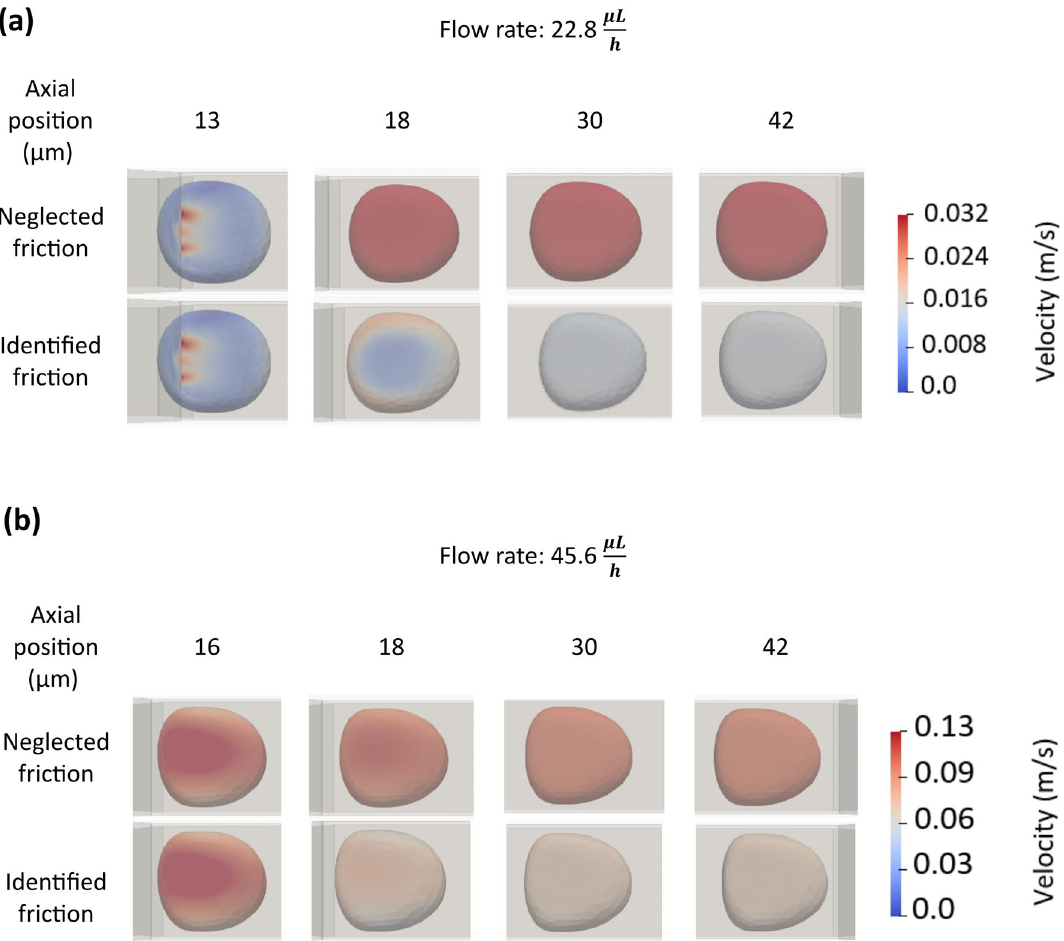
Figure 7. Effects of friction between the walls of the microchannel and the cancer cell on the cell motion and deformation during its transit in the constriction (Step ix in Fig. 3 ) of motion at the flow rates of 22.8 µL/h ( a ) and 45.6 µL/h ( b ). The cell is viewed from the top (perpendicular to the microchannel axis). Because neglecting friction caused the cell to pass very fast, instead of time-matched states, axial location-matched states are